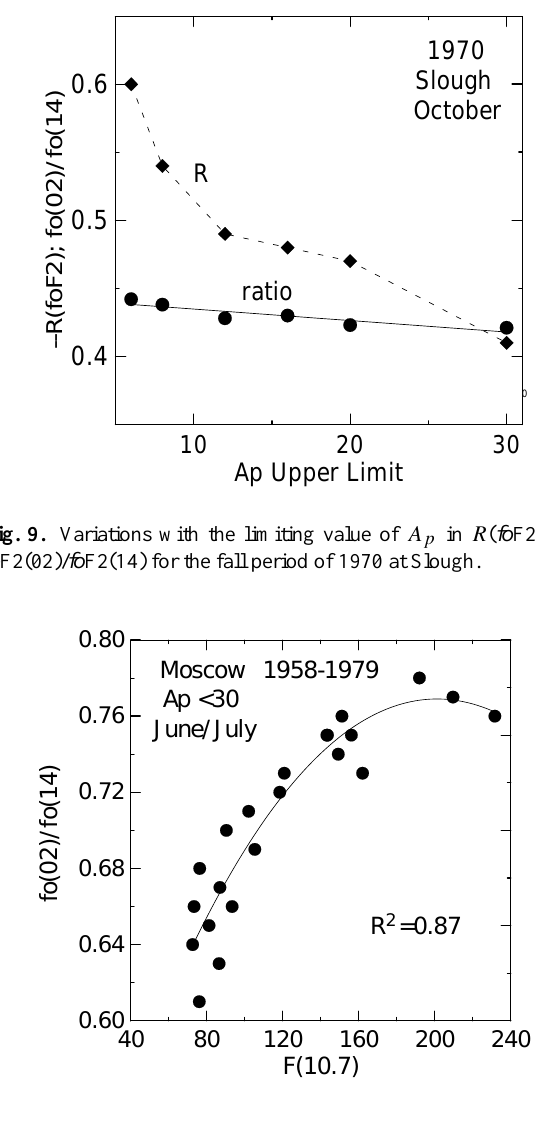
Fig. 10. The fo (02)/ fo (14) dependence on the solar activity index F(10.7) for Moscow. Solid line shows the approximation of the points by a 3rd degree